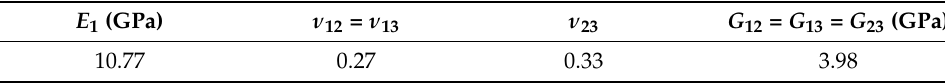
Table 4. The mechanical properties of GFRP profile [23].